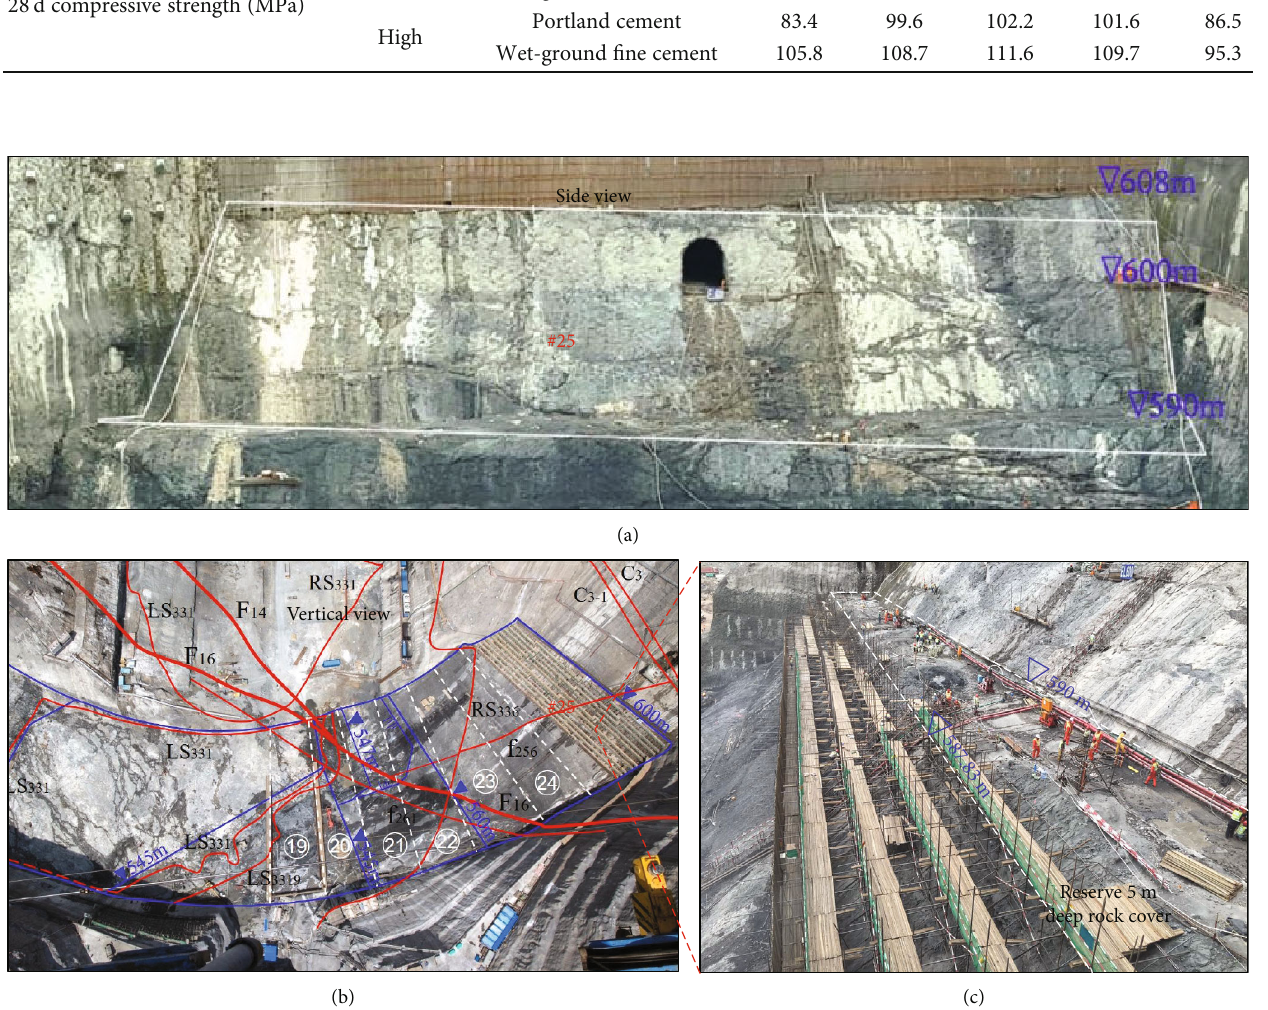
Figure 5: Location of overburden consolidation grouting in the #25 dam